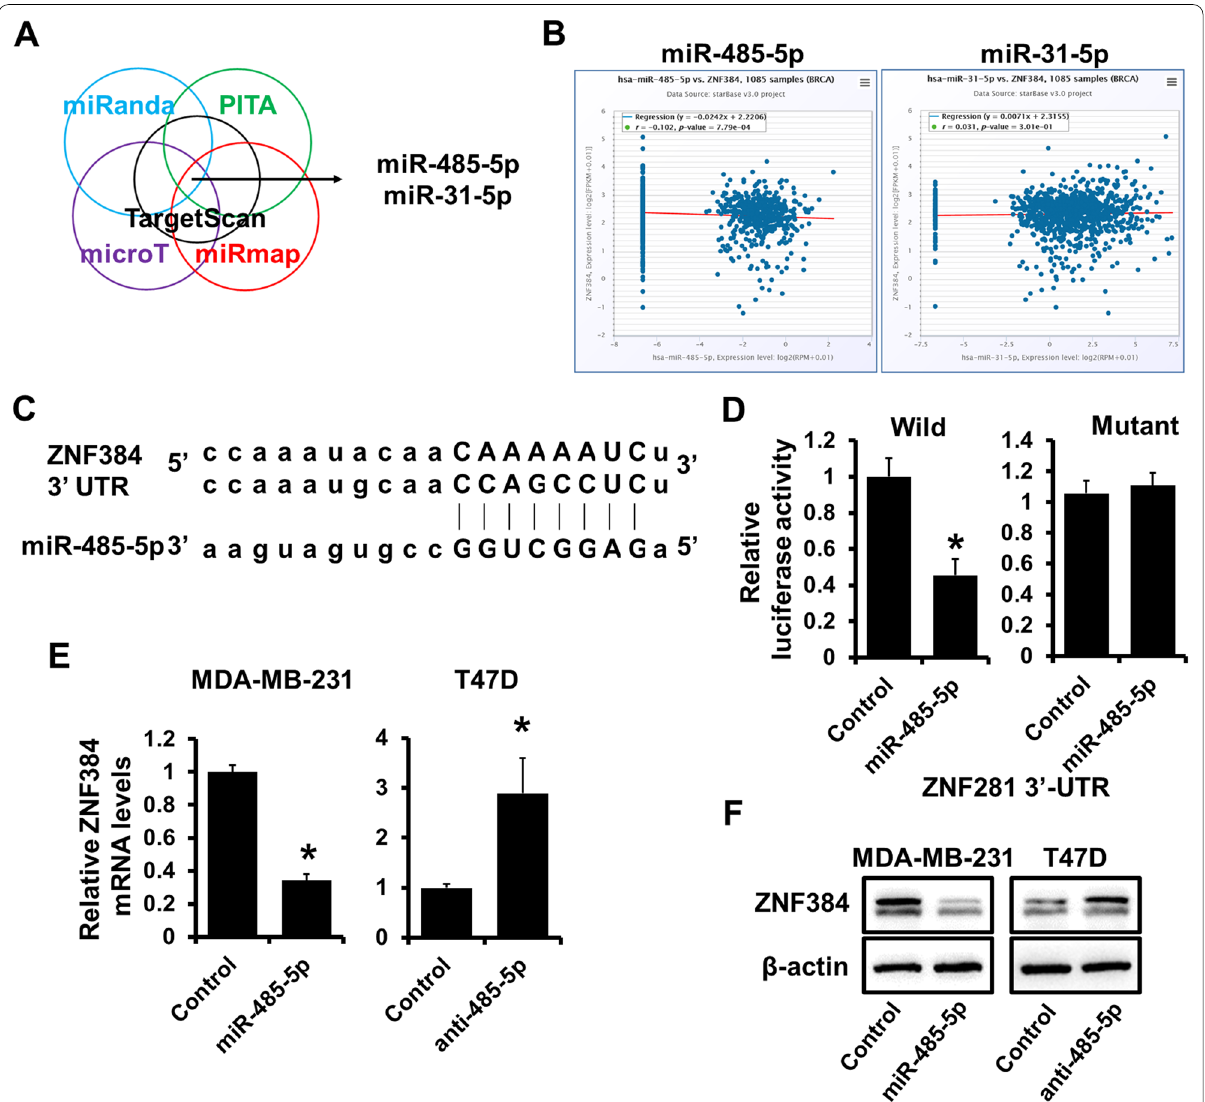
Fig. 6 ZNF384 is a target of miR‑485‑5p. A ZNF384 identified as a target of miR‑485‑5p and miR‑31‑5p using multiple target‑predicting